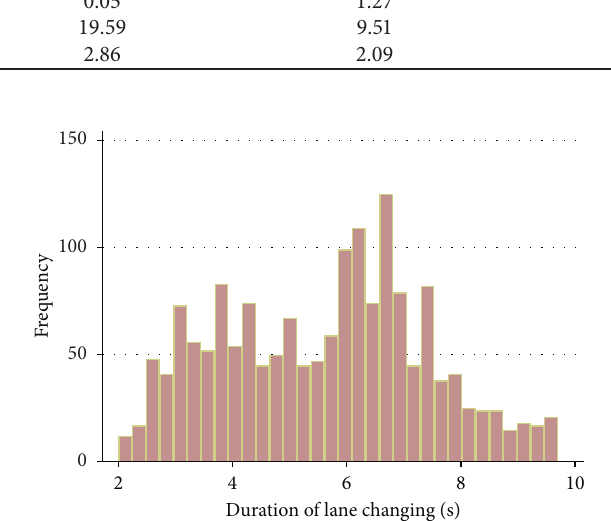
Figure 5: Duration of lane-changing